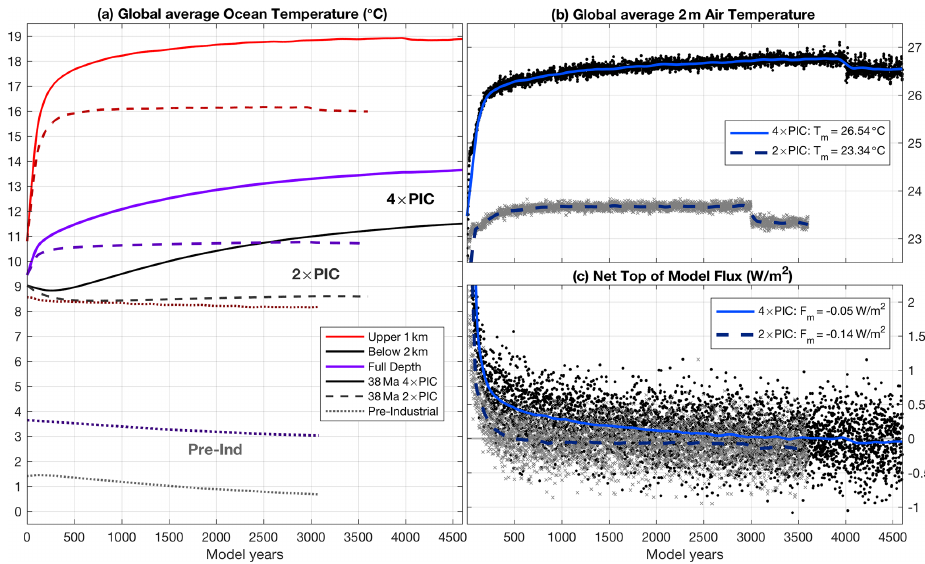
Figure 2. (a) Time series of global upper 1km (red), below 2km (black), and full-depth (purple) volume-weighted average temperature for the complete pre-industrial reference (dotted), 38Ma 2 × PIC (dashed), and 4 × PIC (solid) spin-up simulations. (b) Global average near- surface air temperature for the 38Ma cases (markers: annual, grey crosses: 2 × PIC, black dots: 4 × PIC, lines: smoothed–dashed dark blue: 2 × PIC, solid light blue: 4 × PIC), with mean values over the last 200 years given. (c) Globally integrated top-of-model net fluxes for both 38Ma Eocene cases using the same marker and line conventions as in (b)